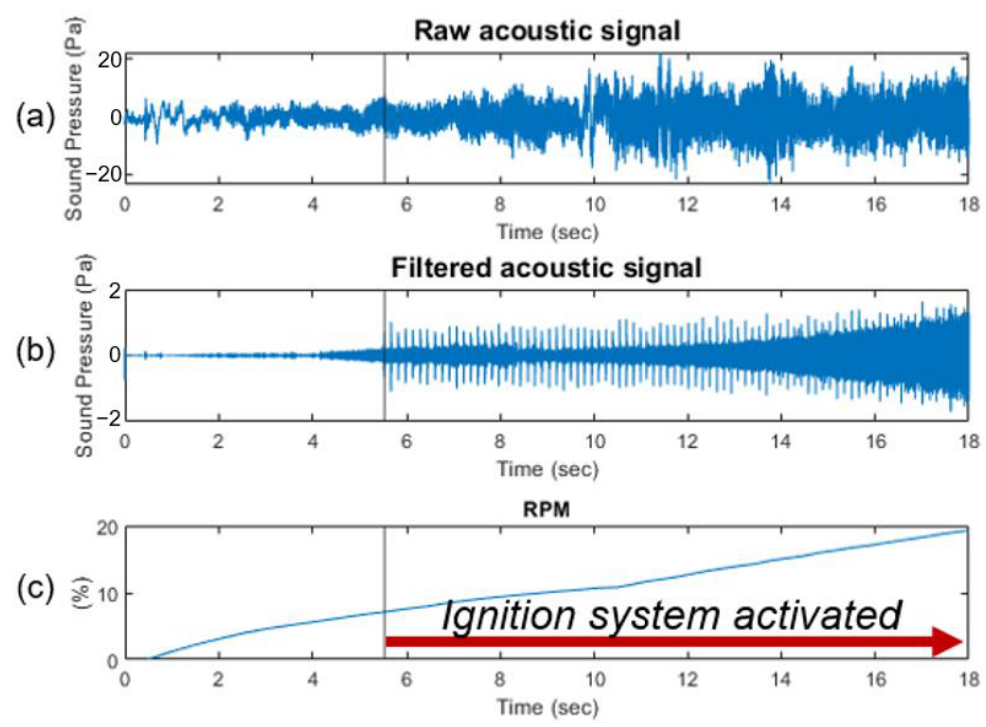
Figure 6. Results of the application of high-pass filtering on acquired data: ( a ) raw acoustic data; ( b ) filtered acoustic data; ( c ) APU RPM.